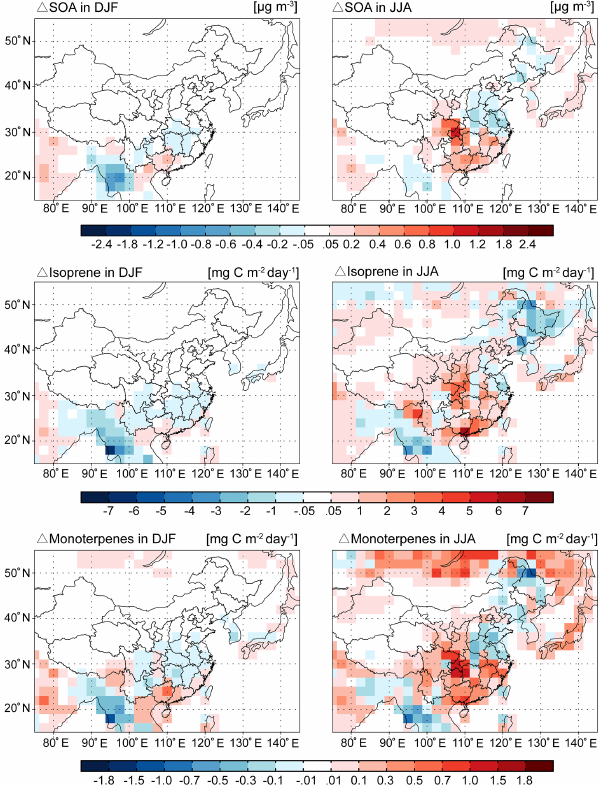
Figure 8. Changes in surface secondary organic aerosol (SOA) con- centration, isoprene emission, and monoterpene emission in winter (DJF) and summer (JJA) across East Asia arising from 1980–2010 changes in land cover and land use alone ([ CTRL ] – [ S_LCLU